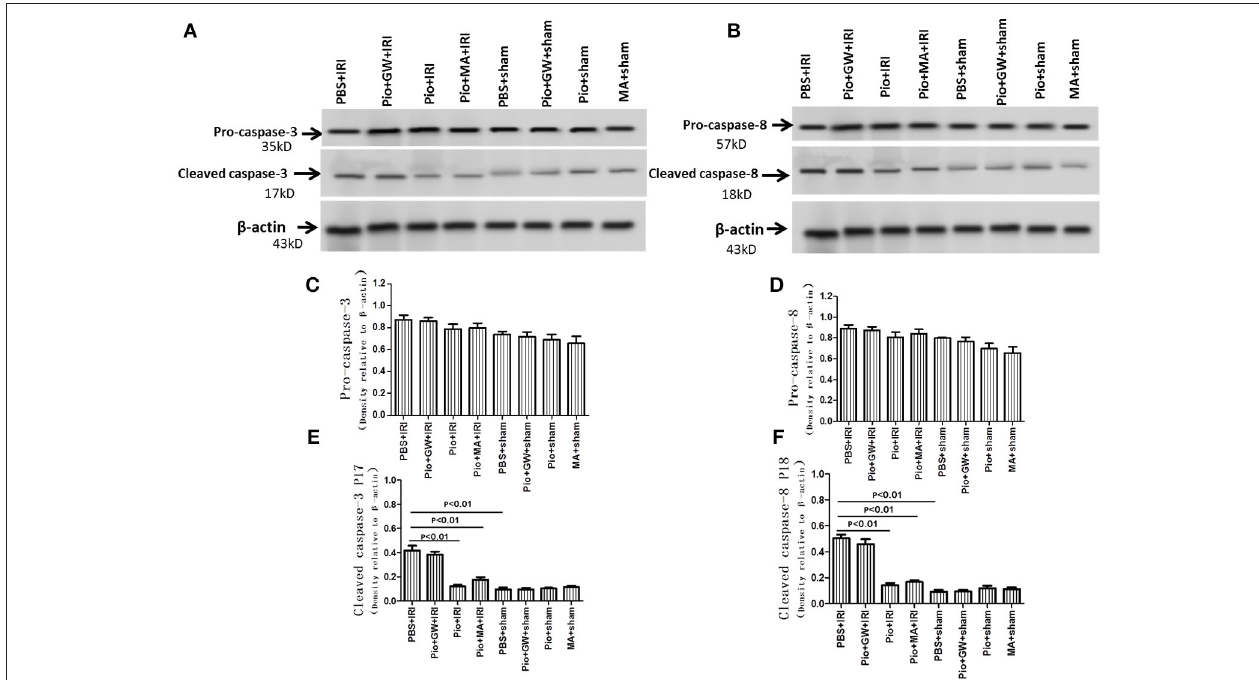
FIGURE 11 | Expression of caspase-3 and caspase-8 protein in renal tissue at 24h after renal IRI. (A) Representative western blots show pro-caspase-3 and cleaved caspase-3 P17 protein levels in the kidneys. (B) Representative western blots show pro-caspase-8 and cleaved caspase-8 P18 protein levels in the kidneys. (C–F) Quantitative analysis of caspase-3 and caspase-8 protein levels in the kidneys. Values are expressed as means ± SE (C–F) . n = 6 in each group.